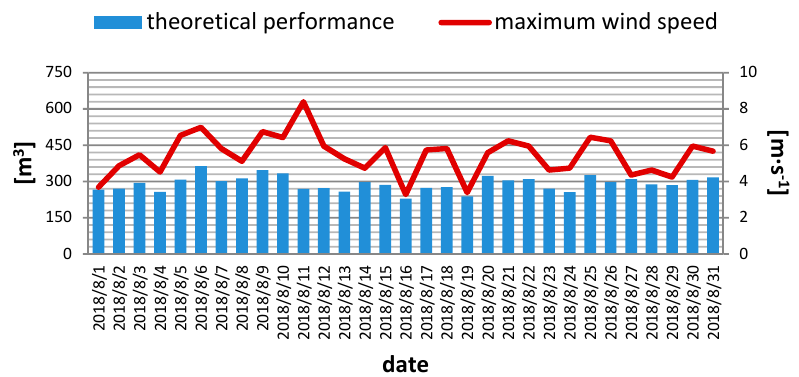
Figure 8. E ffi ciency of the pulverization unit of the aerator in July. Figure 8. Efficiency of the pulverization unit of the aerator in July.